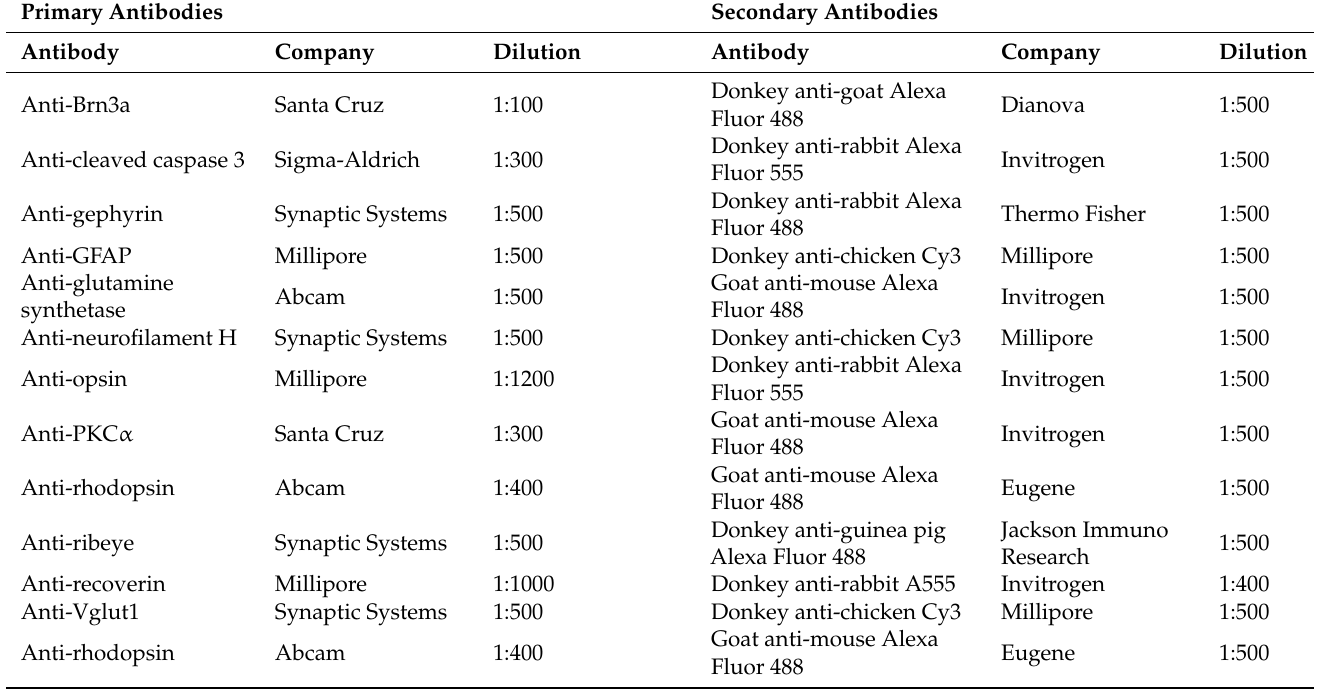
Table 1. Primary and secondary antibodies used for